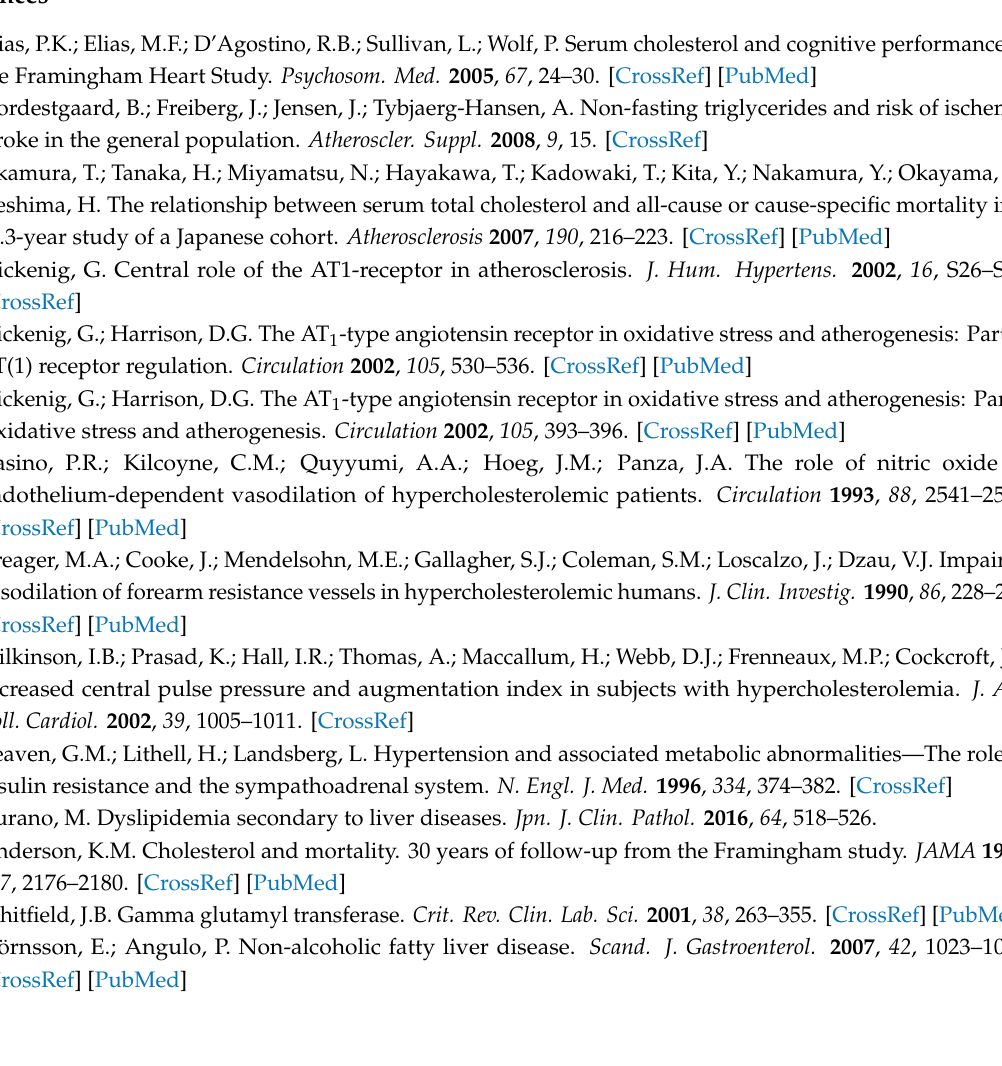
Figure S1: ORs with 95% CI for hypertension stratified by unadjusted liver enzymes quartile. The quartile with the lowest liver enzymes is used as reference. Q1 indicates first quartile and so on. (A) ALP, p = 0.994; (B) GGT, p < 0.001; (C) AST, p = 0.035; (D) ALT, p = 0.067. * p < 0.05 and ** p < 0.01 vs. Q1. Analyzed by Logistic regression analysis. Hosmer and Lemeshow’s goodness of fit test (x 2 > 0.05). Abbreviation: ALP, alkaline phosphatase; GGT, gamma-glutamyltransferase; AST, aspartate aminotransferase; ALT, alanine aminotransferase; OR, odds ratio; Cl, confidence interval, Table S1: Cardiovascular risk factors along the ALP quartiles; Table S2: Cardiovascular risk factors along the GGT quartiles; Table S3: Cardiovascular risk factors along the AST quartiles; Table S4: Cardiovascular risk factors along the ALT quartiles; Table S5: Cardiovascular risk factors along the GGT quartiles in male; Table S6: Cardiovascular risk factors along the GGT quartiles in